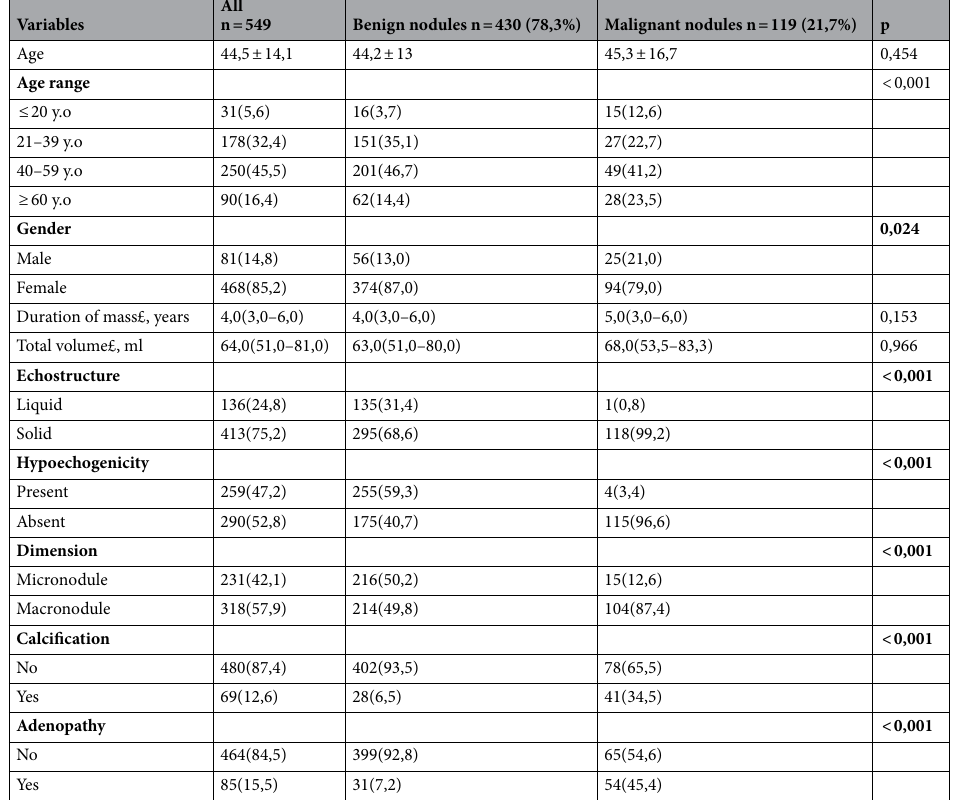
Table 1. Clinical and ultrasound characteristics for all patients and according to the nature of the mass. Values are mean ± standard deviation or absolute value and percentage in parentheses. £ = the median and the 95% confidence interval. Ml = mililiter. Significant values are in [bold].